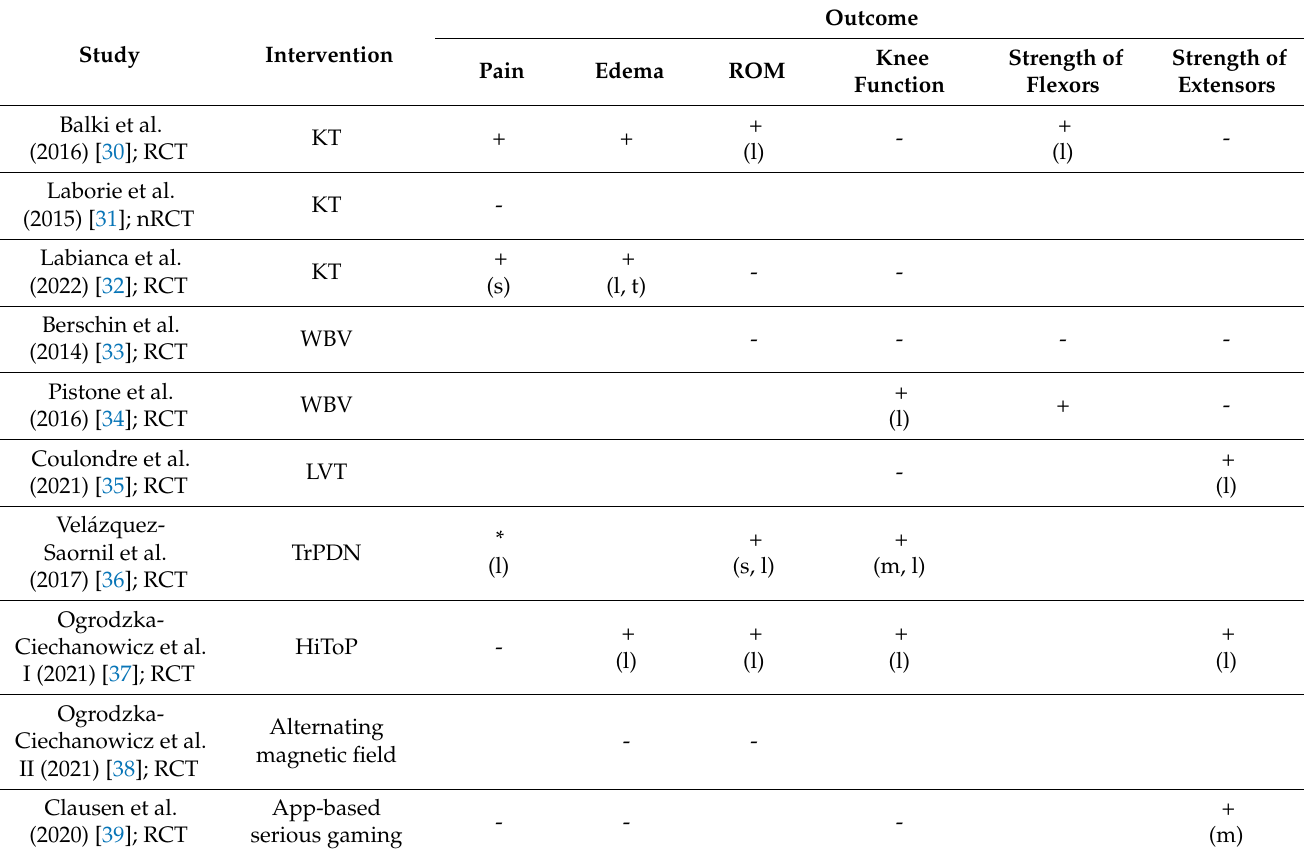
Table 2. Subgroup analysis with synthesis of the